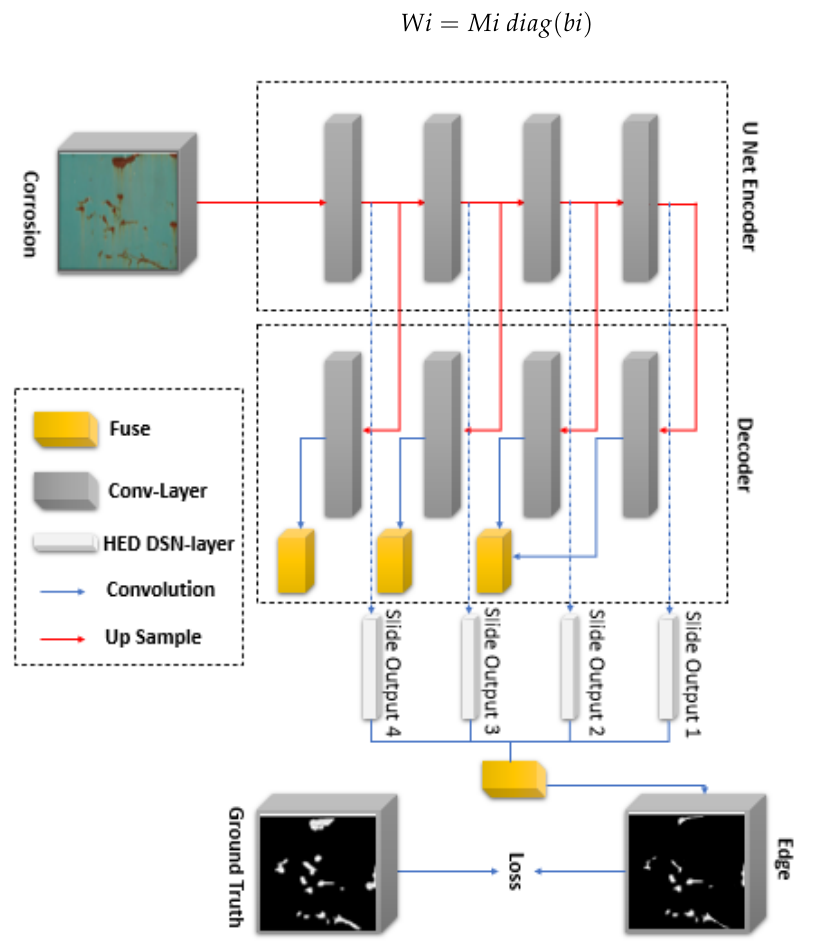
Figure 6. A representation of multiple layer CNN architecture based on 16 convolutional layers.